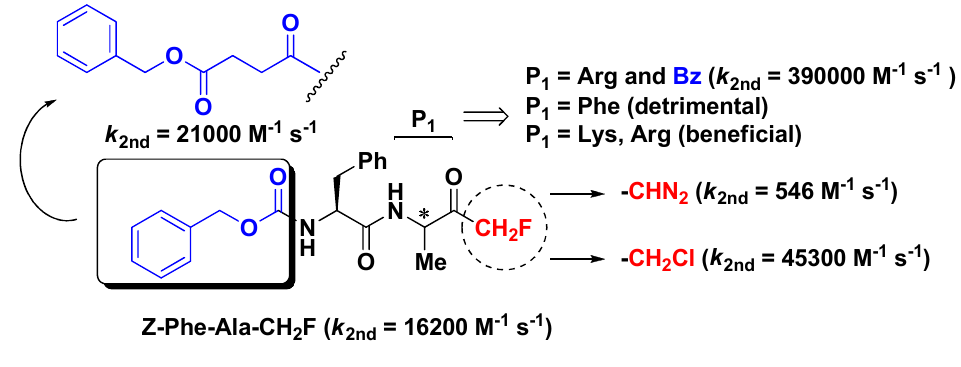
Figure 2. Chemical structure, Cat-B inhibitory potency, and most relevant modifications of the first synthesized m-PFMK.